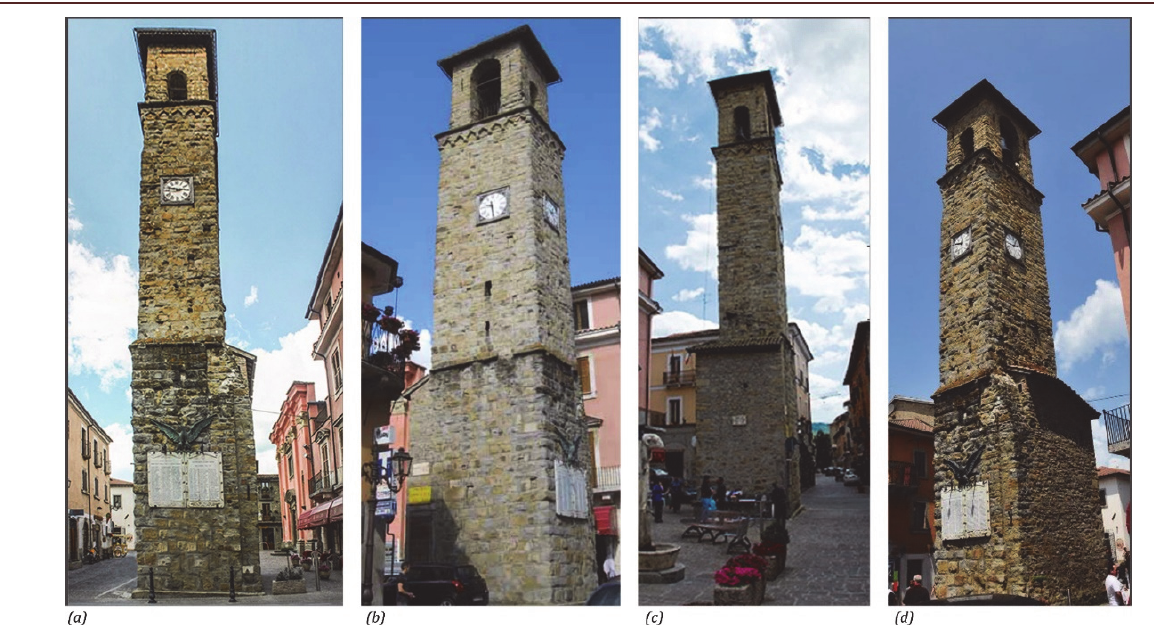
Figure 4: Views of the façades of the civic clock tower of Amatrice (Rieti, Italy) before the Central Italy seismic sequence of 2016 Furthermore, as clearly visible in Fig. 5, three distinct sections are recognisable along the vertical structure, highlighted by decorative frames and visible reductions of the wall thickness.